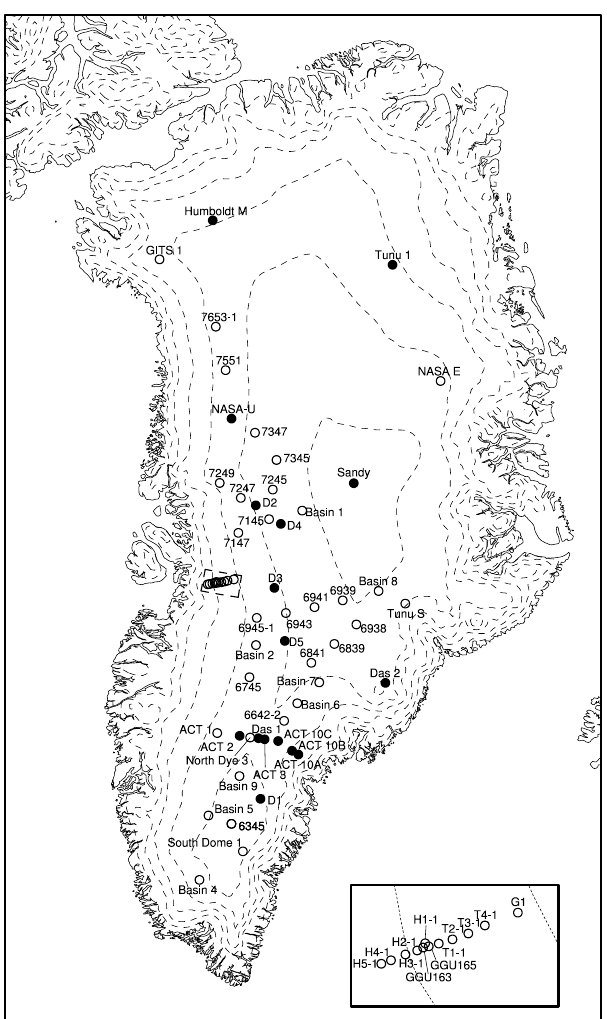
Figure 2. Map of Greenland showing the 62 firn cores used for validation of the firn model. Solid circles represent firn cores longer than 30m; open circles are firn cores shorter than 30m. The inset in the lower right shows cores from Harper et al. (2012) in the west Greenland percolation area around 69 ◦ 42 (cid:48) N. Dashed contours are surface elevation isolines with a spacing of 500m, the uppermost being